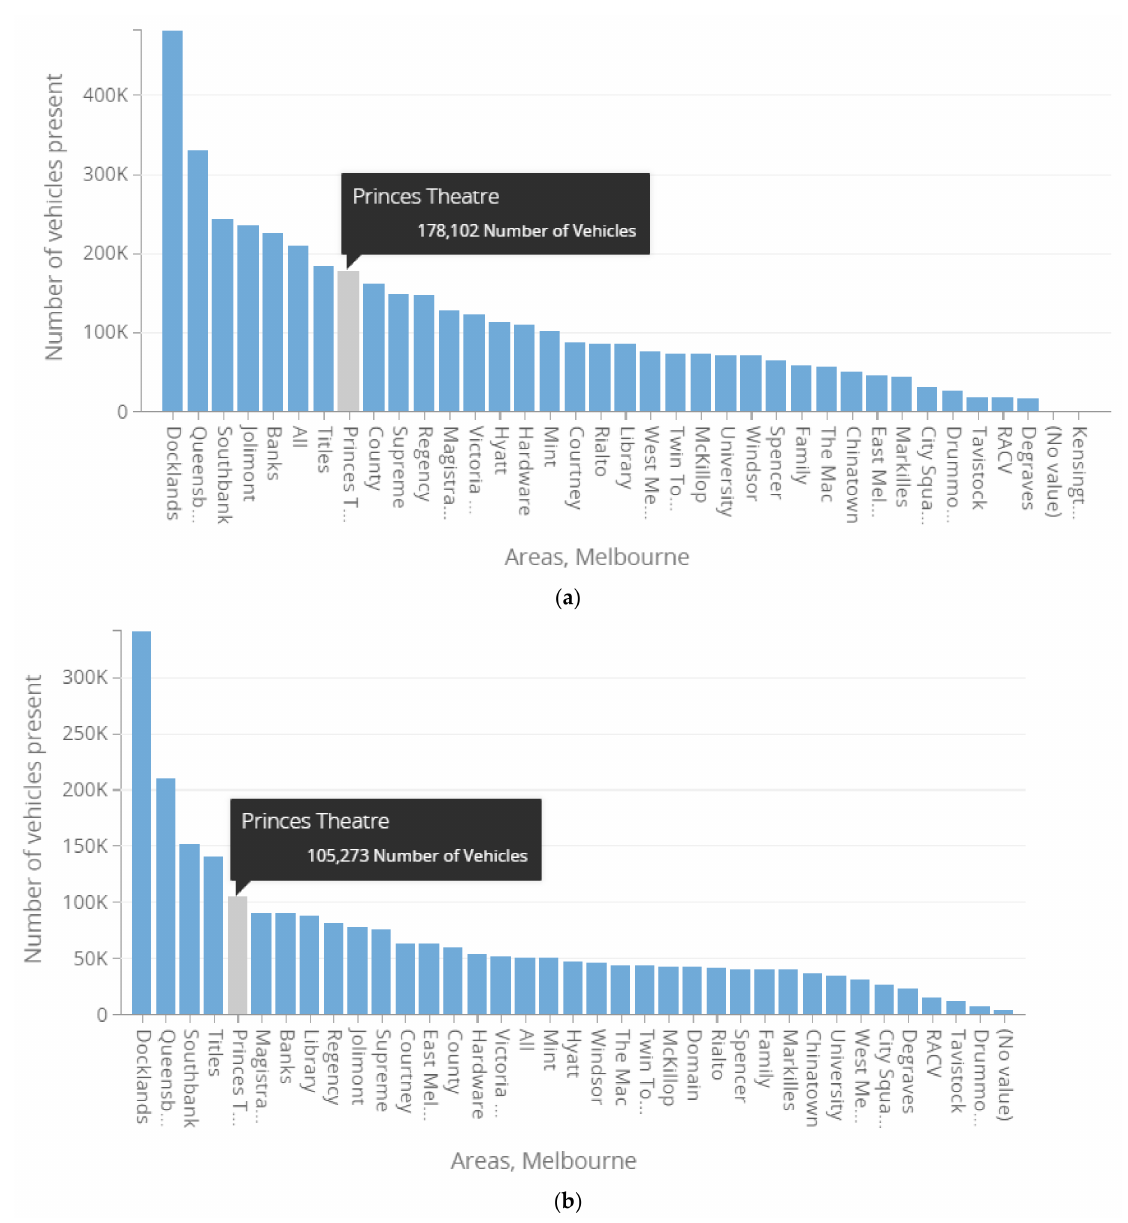
Figure 6. Bar graph representation of Princess Theatre’s area parking volume in terms of vehicles present between two periods: ( a ) 16 March to 26 May 2019 versus ( b ) 16 March to 26 May 2020. Table 4. Area level comparisons of the average parking duration change in minutes between